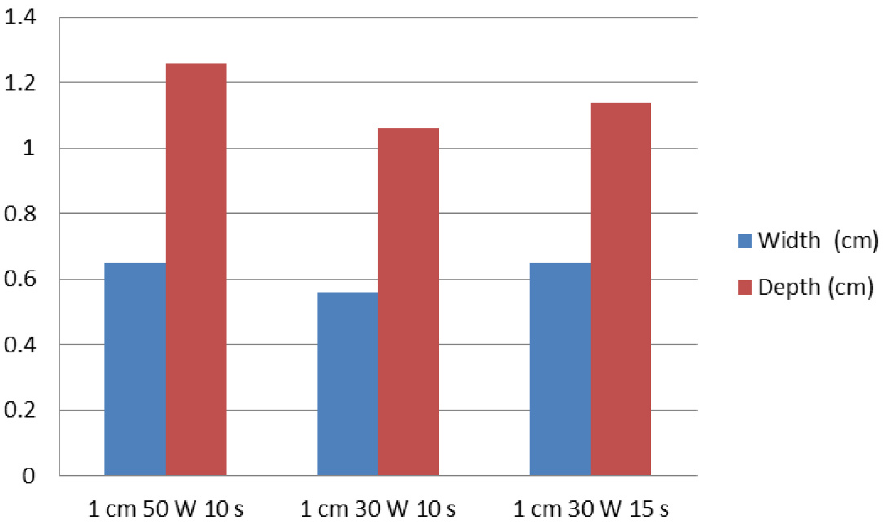
Figure 5. A graph of ablation effect according to the RFA power and ablation time. The vertical axis represents the width (cm) and depth (cm) of ablation zones.